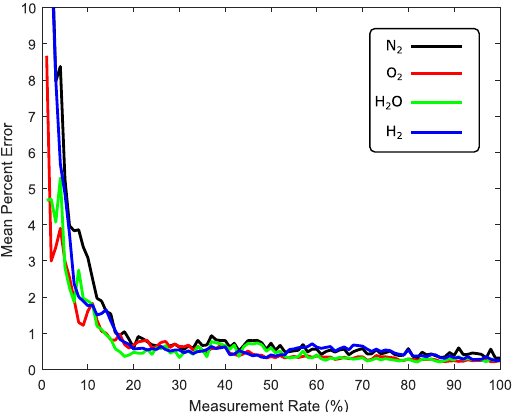
Figure 5. Mean percent error of the mole fractions (calculated from the reconstructed Raman image) relative to the calibrated average Raman image, for N 2 (black), H 2 (blue), H 2 O (green) and O 2 (red) measured 5.5 mm from the nozzle. The measurement rate M / N refers to the fraction of CS measurements M relative to the number of pixels in the image N